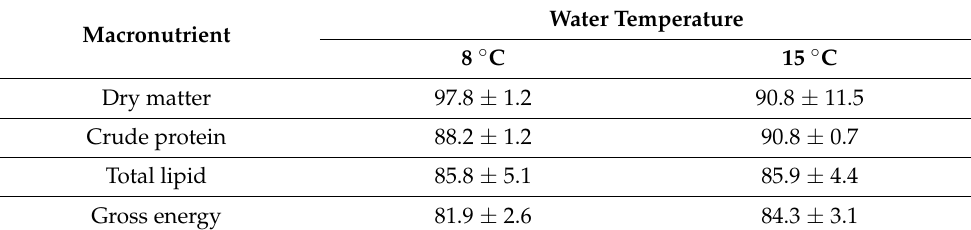
Data represent the mean ± standard deviation of three replicate tanks (measured duplicate fecal samples from each